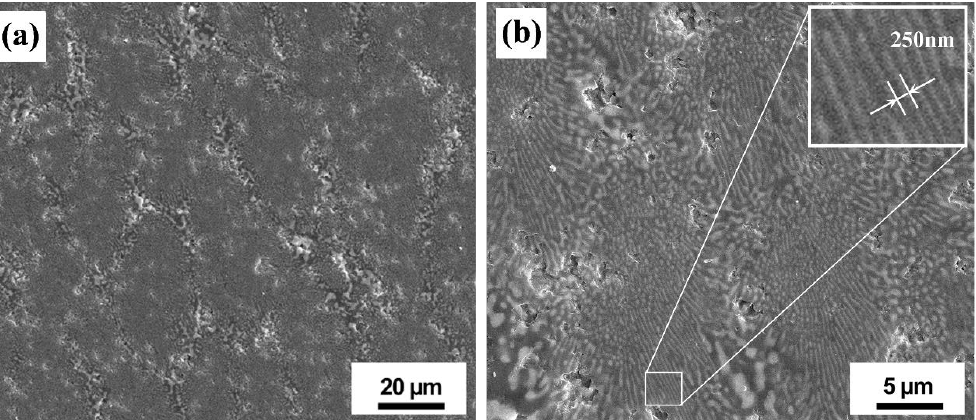
Figure 9. The back-scattering electron image showing the microstructure of the Al 2 O 3 -ZrO 2 (Y 2 O 3 ) nanoeutectic: ( a ) typical colony eutectic and ( b ) enlarged view of ( a ). Reproduced with permission from Reference [100], Copyright © 2018 Elsevier Ltd.